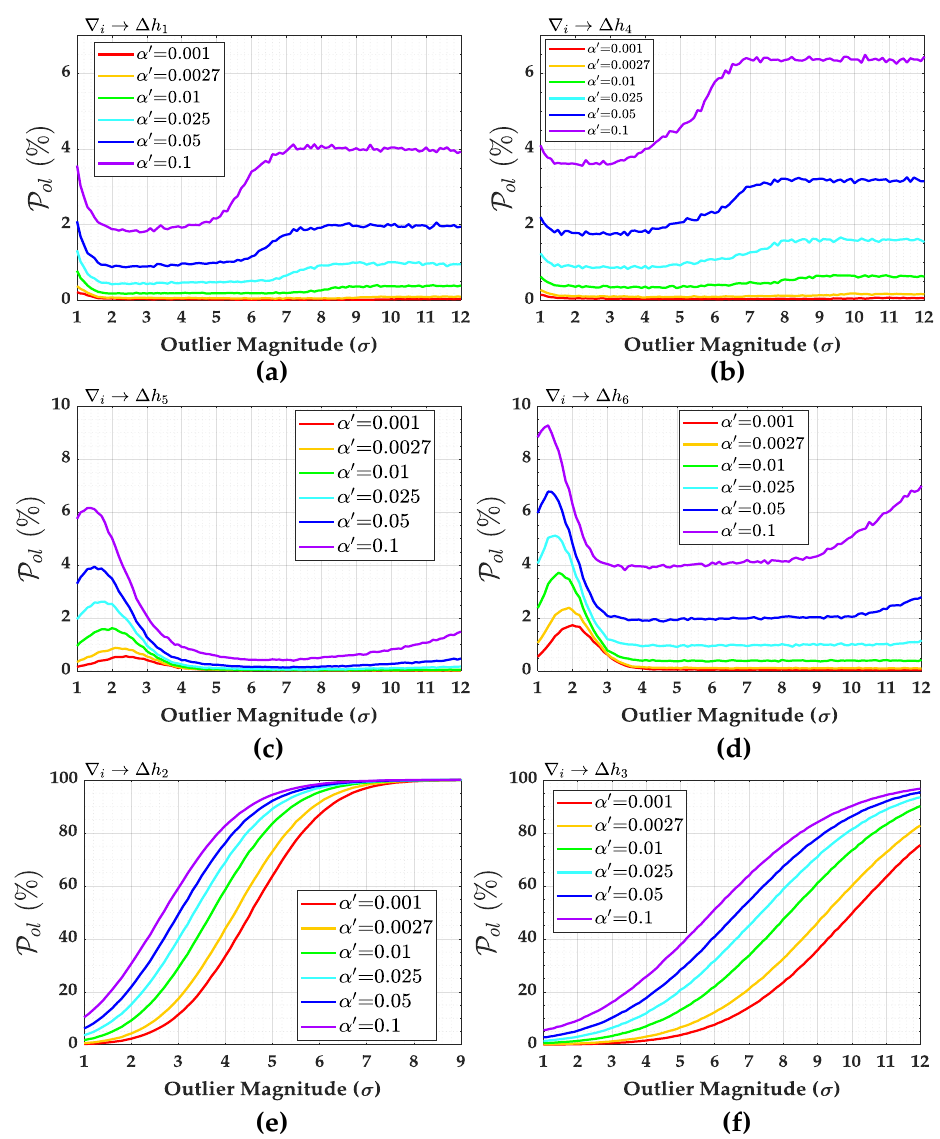
Figure 21. Probability of statistical overlap ( P ol ) for network ( b ). ( a ) P ol for ∆ h 1 . ( b ) P ol for ∆ h 4 . ( c ) P ol for ∆ h 5 . ( d ) P ol for ∆ h 6 . ( e ) P ol for ∆ h 2 . ( f ) P ol for ∆ h 3